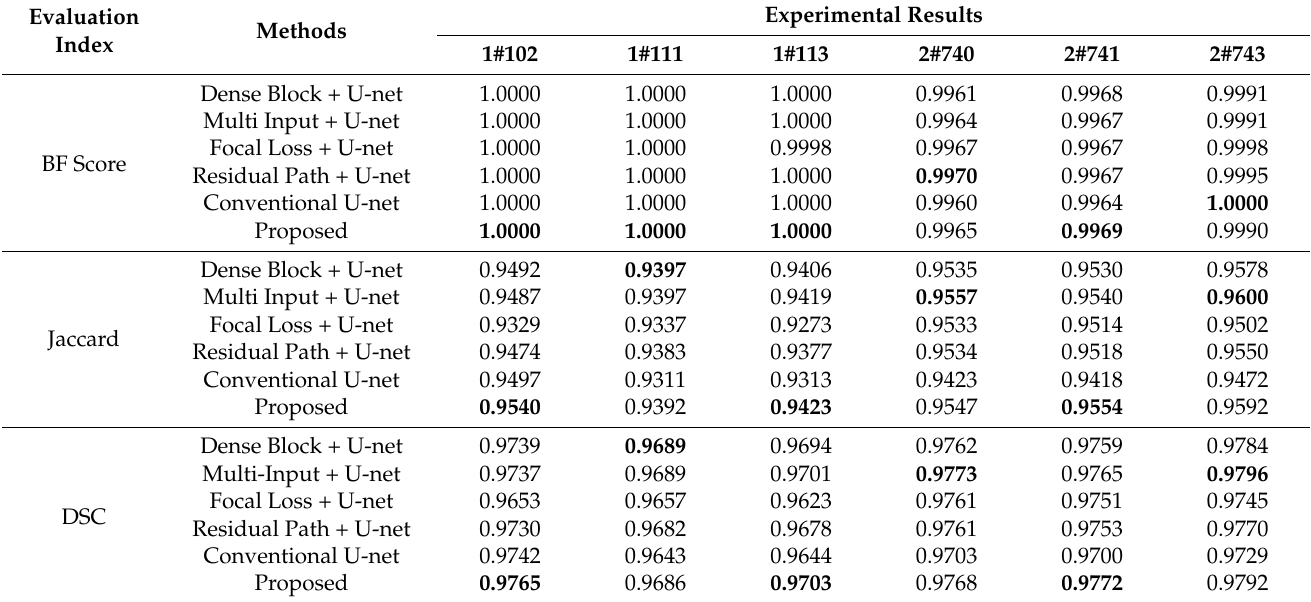
Table 4. Ablation experiments of the proposed approach.